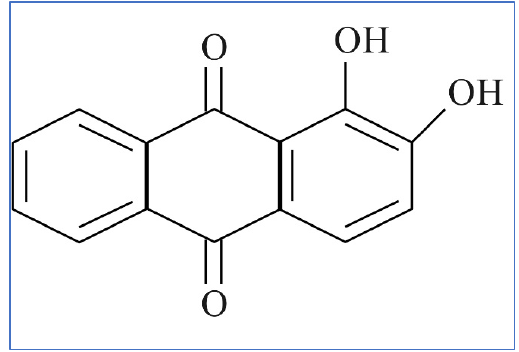
Figure 14. Structure of mordant red 11.